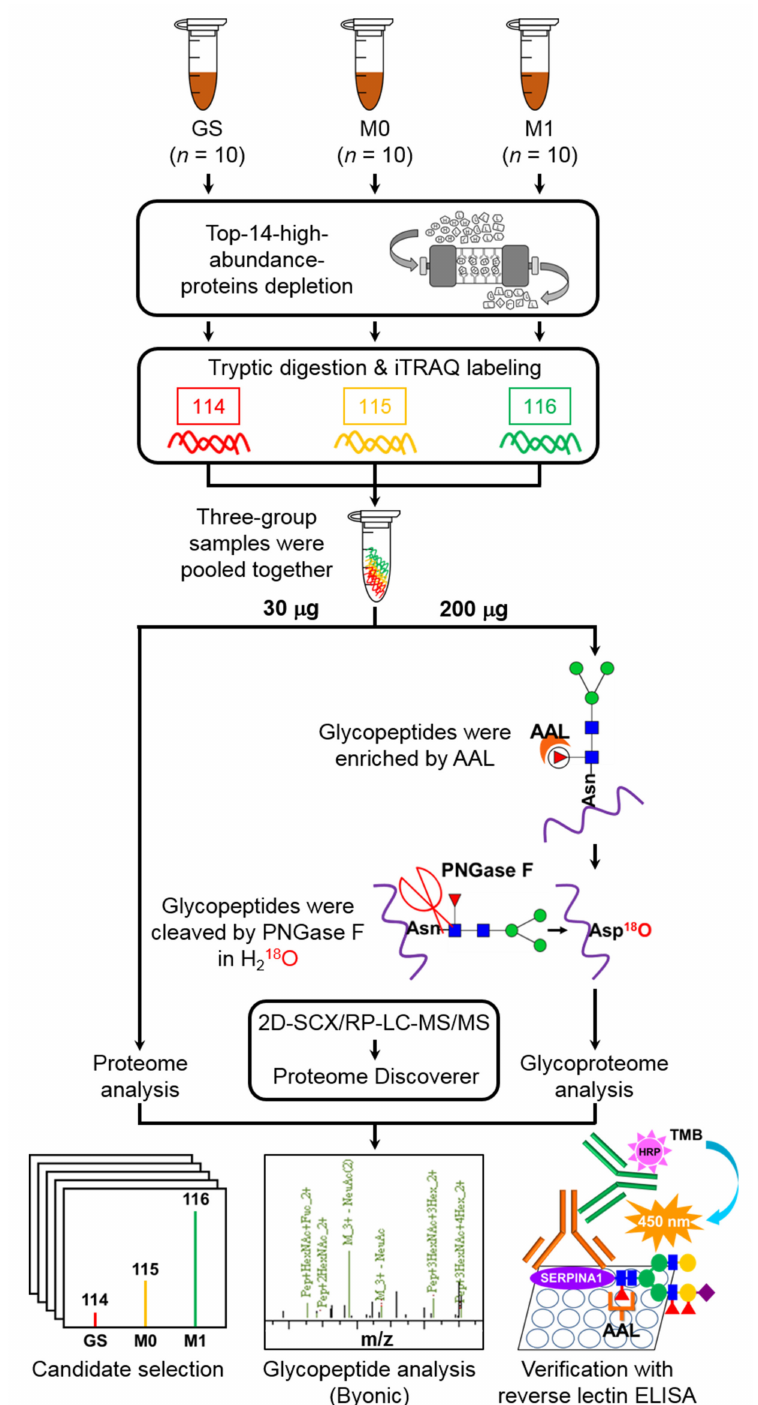
Figure 1. Schematic representation of the experimental design of this study. iTRAQ labeling coupled with 2D-SCX/RP-LC-MS/MS was applied for comprehensive analysis of the proteome profile of plasma samples from patients with PC, including non-metastatic (M0) and metastatic (M1) pancreatic cancers and subjects with gallstone lesions (GS). AAL was employed to enrich glycopeptides with specific glycan and H 2 18 O to label glycosylated sites via PNGase F-mediated reaction for glycopro- teome profiling analysis. We selected 18 O-labeled fucose-containing glycopeptides upregulated in PC plasma samples as candidate targets. Fuco-SERPINA1, one of the candidate proteins, was selected for validation in plasma samples of PC and GS using reverse AAL-based